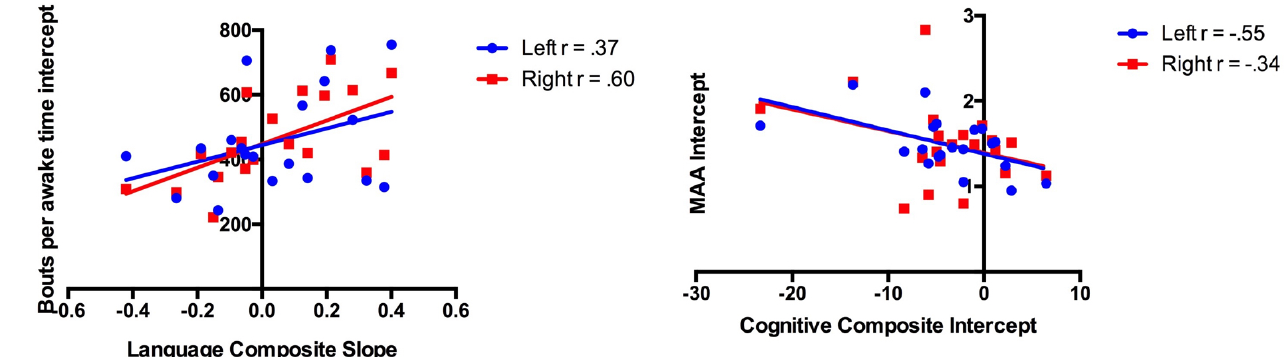
Figure 8. Scatter plot of mean average acceleration (MAA) intercepts (for right and left arms) and Bayley composite cognitive intercepts of each infant.